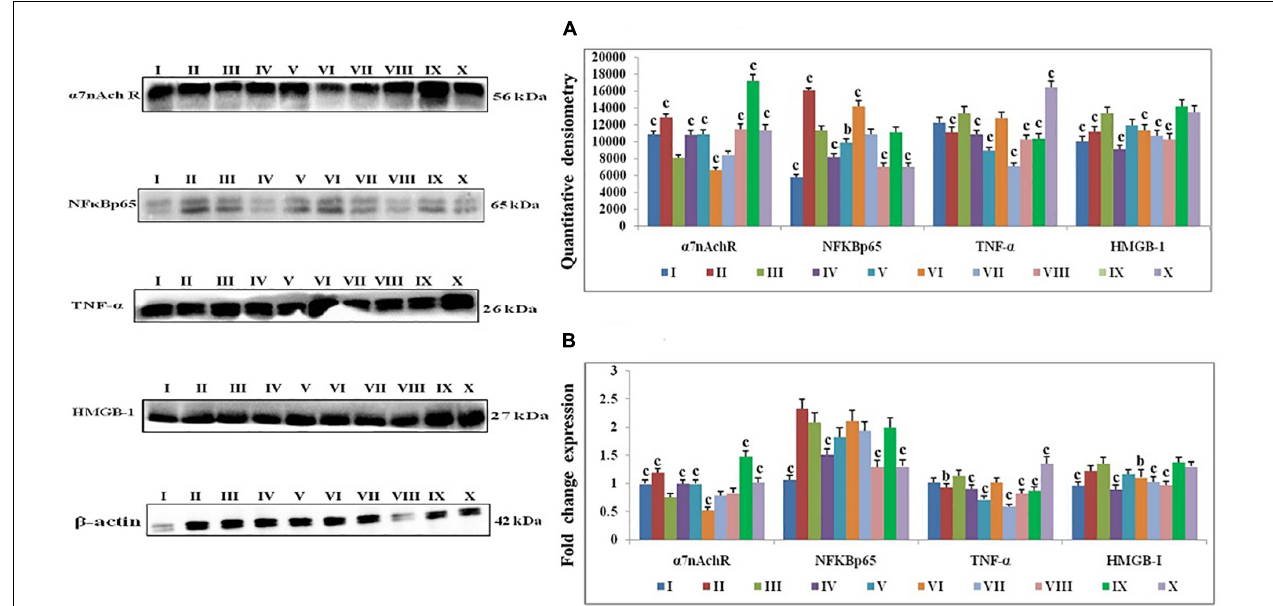
FIGURE 4 | Effect of taVNS on cholinergic anti-inflammatory pathway in DMH induced colon carcinogenesis. The details of groups as follows for western blot analysis – I-Control, II-taVNS control, III-DMH control, IV-taVNS 1, V-taVNS 2, VI-taVNS 3, VII-taVNS 4, VIII-taVNS 5, IX-Standard chemotherapy, X-Dummy control. Specific treatments for individual groups mentioned in Supplementary Table 1 . (A) Immunoblotts for α 7nAchR, NF κ B, TNF- α , and HMGB-1 for various groups. The expression of α 7nAchR was decreased while NF κ B, TNF- α , and HMGB-1 increased after DMH treatment. The taVNS treatment resulted in increased expression of α 7nAchR and curtailment of inflammatory markers (NF κ B, TNF- α , and HMGB-1). (B) The mRNA expressions of the above mentioned protein were also in line with the findings of immunoblotting assay. β -actin was used as loading control in immunoblottingand qRT-PCR assay. Each experiment was performed in triplicate. Values are presented as mean ± SD. Comparisons were made by the one-way ANOVA followed by Bonferroni multiple test. All groups were compared to the DMH treated group ( a p < 0.05, b p < 0.01, c p <